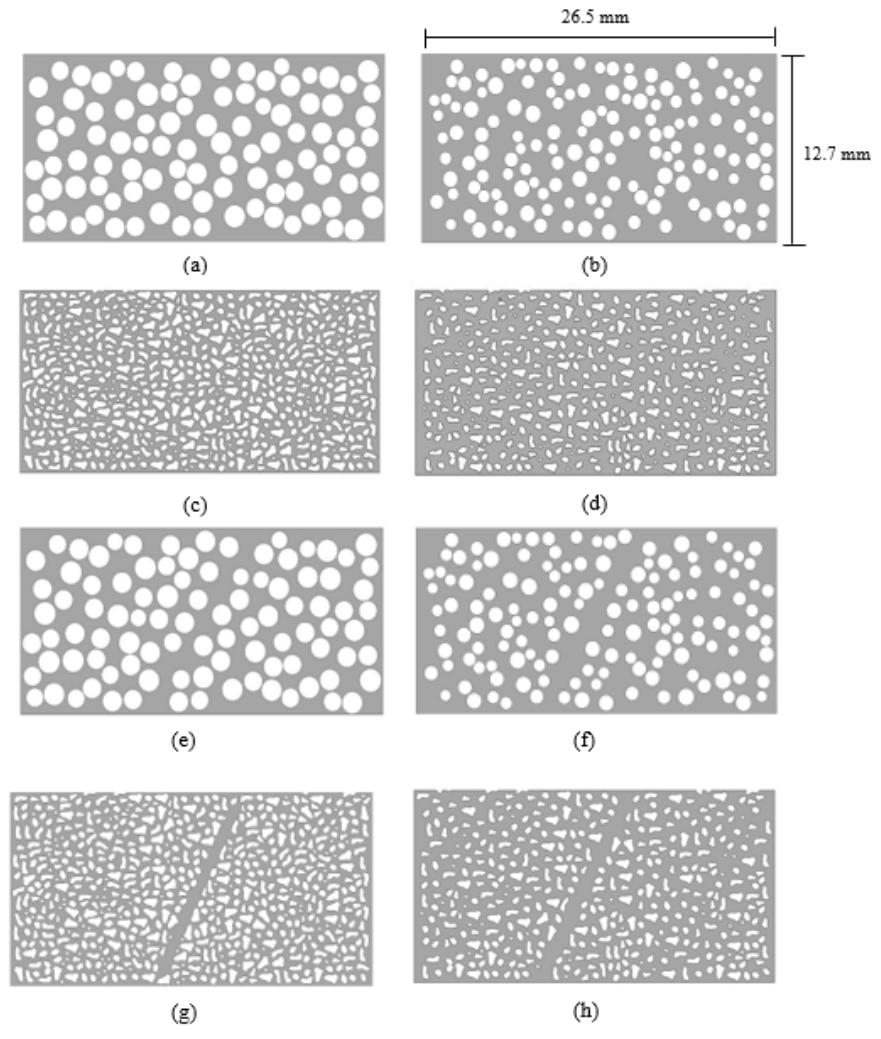
Figure 2. Geometries of the micromodels in Table 3. ( a ) Micromodel with circular grain shape and porosity 0.5. ( b ) Micromodel with circular grain shape and porosity 0.7. ( c ) Micromodel with irregular grain shape and porosity 0.5. ( d ) Micromodel with irregular grain shape and porosity 0.7. ( e ) Micromodel with circular grain shape, presence of preferential flowing channel, and porosity 0.5. ( f ) Micromodel with circular grain shape, presence of preferential flowing channel, and porosity 0.7. ( g ) Micromodel with irregular grain shape, presence of preferential flowing channel, and porosity 0.5. ( h ) Micromodel with irregular grain shape, presence of preferential flowing channel, and porosity 0.7. Table 3. Characteristics of the micromodels. 3.2.